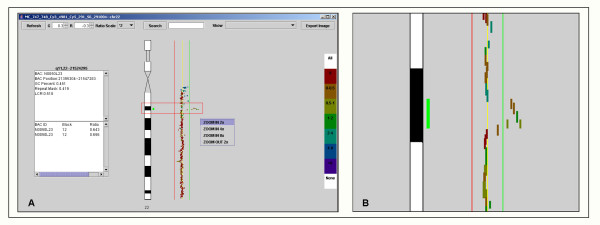
Chromosome Display: (A) Detection of a copy number polymorphism, which encompass about 300 kb. (B) Zoom-in view of the relevant region (red rectangle in (A)).